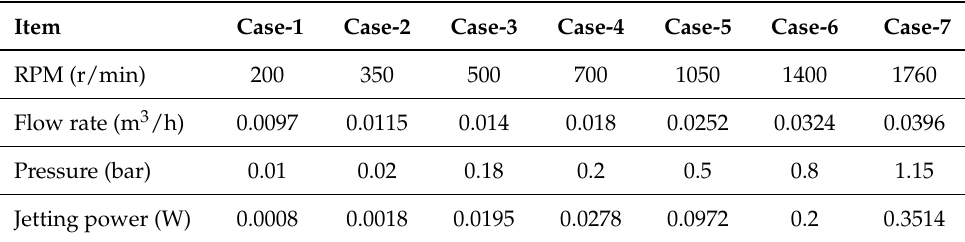
Table 3. Pump RPM and corresponding flow rate, pressure, and jetting power.